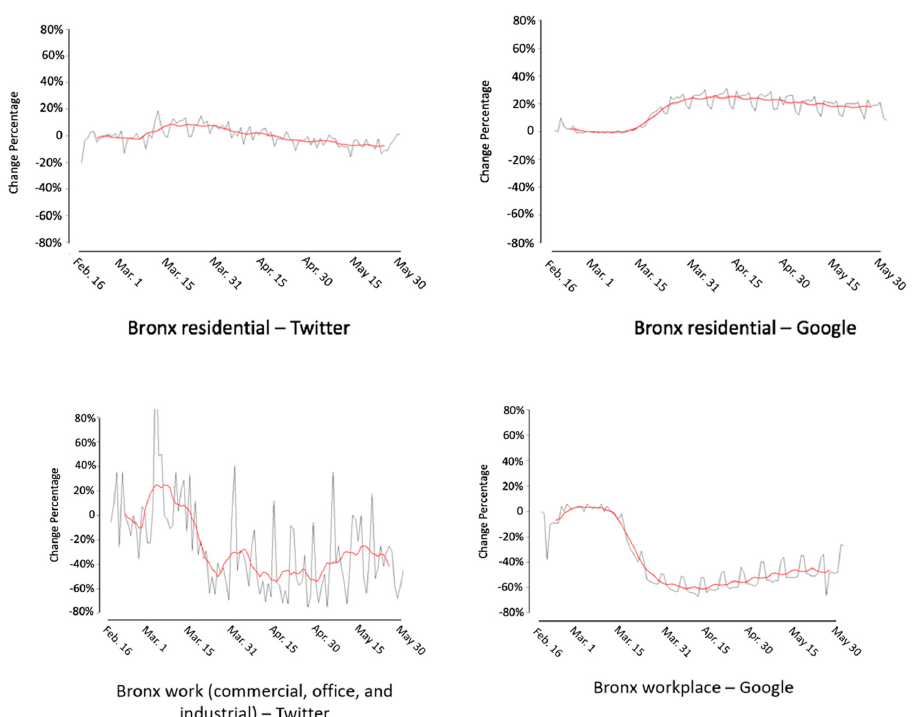
Figure 4. Twitter- and Google-based human mobility changing patterns in Bronx County.